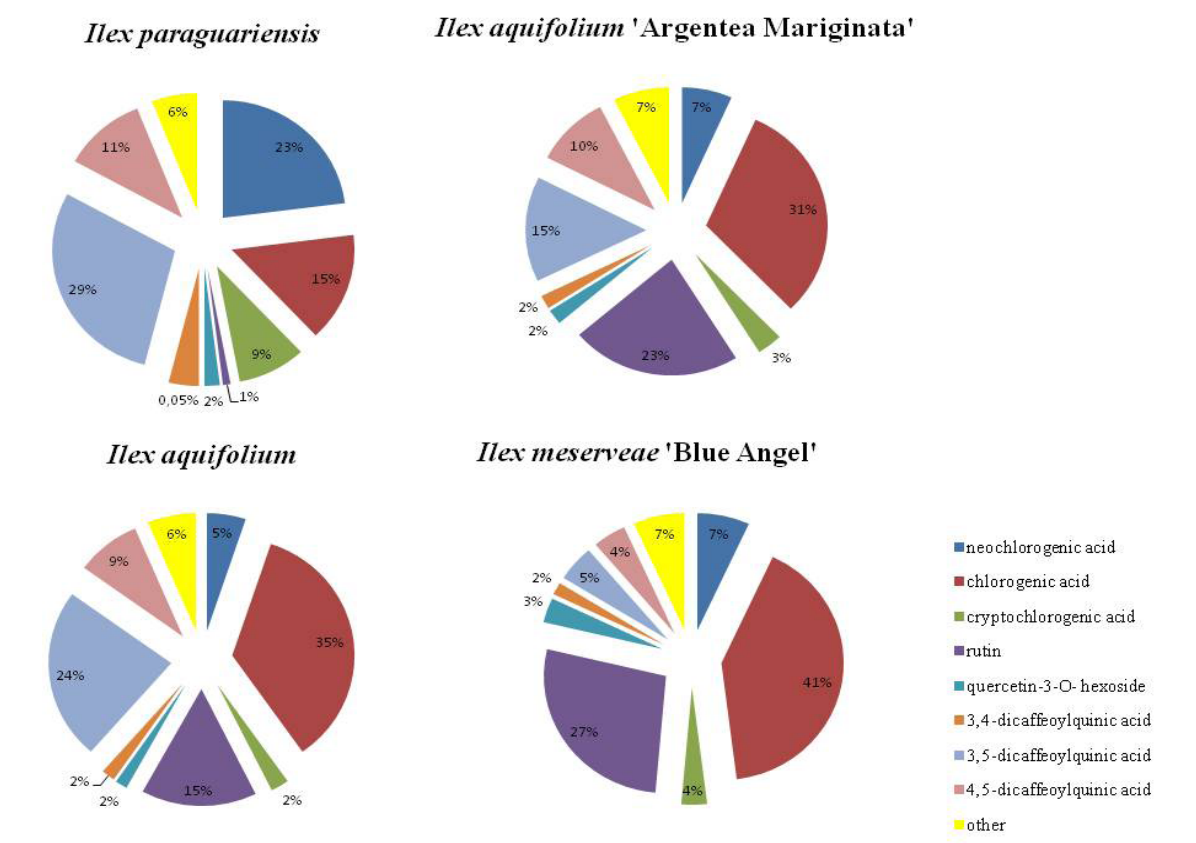
Figure 1: The mean share of phenolic compounds in Ilex